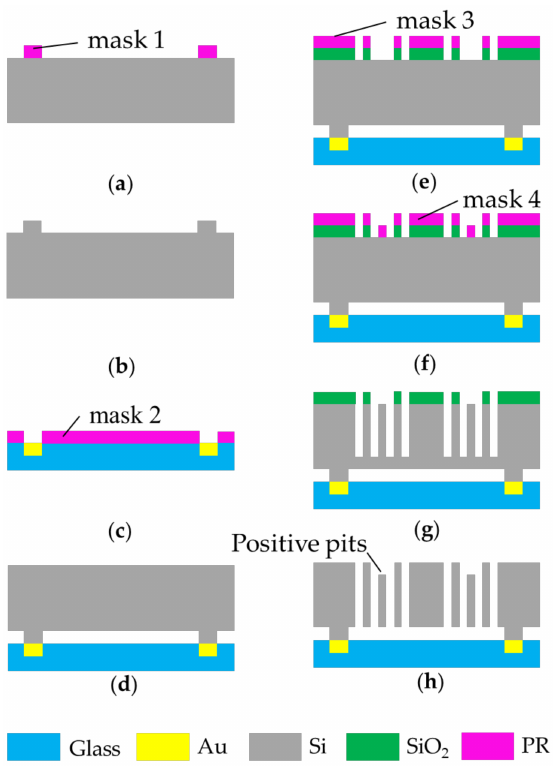
Figure 4. Process flow of three-axis accelerometer. ( a ) Position of anchors determined by mask 1; ( b ) overall etched silicon with ICP; ( c ) Ti and Au deposited on glass; ( d ) anodic bonding; ( e ) position of out-of-plane movable finger determined by mask 3; ( f ) the position of the finger and the through hole defined by mask 4; ( g ) the silicon etched 50 µ m depth by ICP; ( h ) the positive pits etched by ICP.